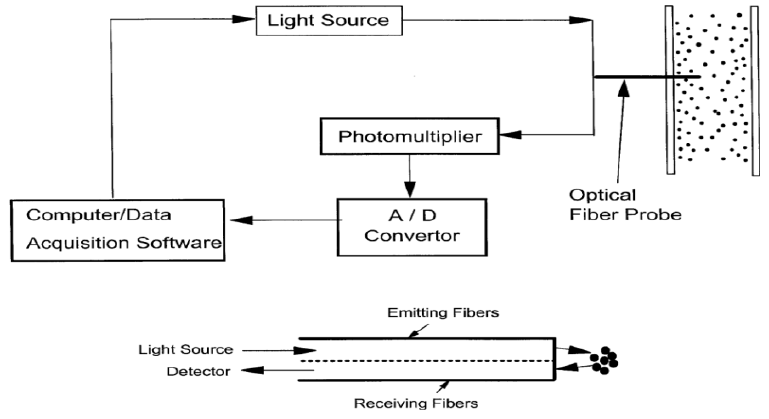
Figure 6. The fi ber-optical probe system for solids holdup